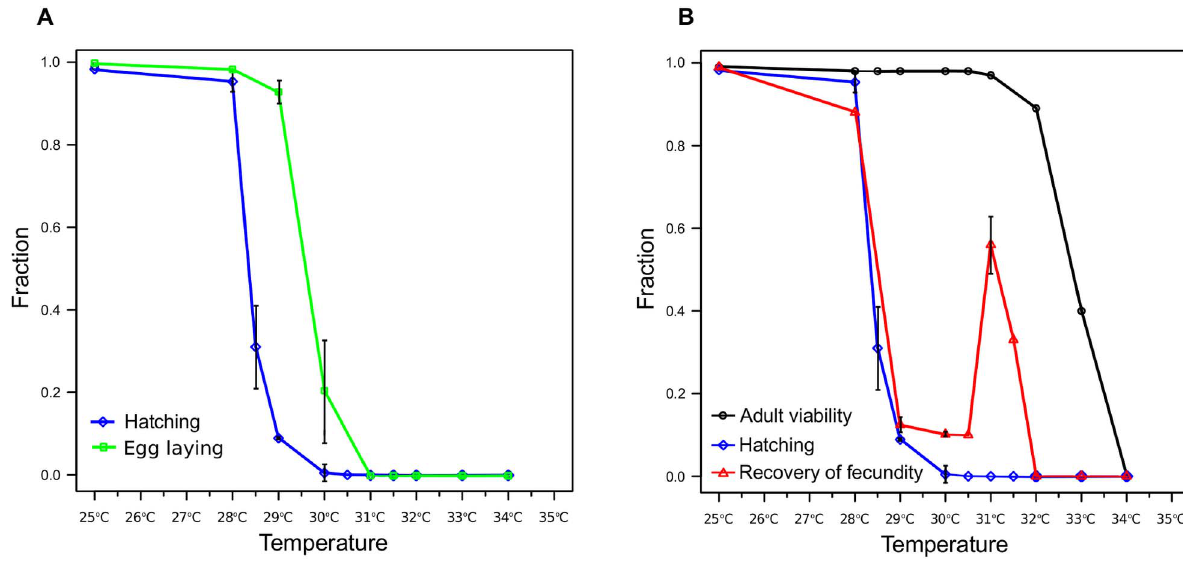
Figure 2. Reproduction across a range of chronic stress temperatures. (A) Fractions of embryos laid at 20 u C that hatch after 24 hours at a given stress temperature (blue) and fraction of adult worms that lay eggs at a given temperature (green). (B) In addition to the same hatching curve as in A, fractions of worms that recover fecundity following 24 hours at a given stress temperature (red) and adult viability after 24 hours (black) are shown. Error bars represent s.d.